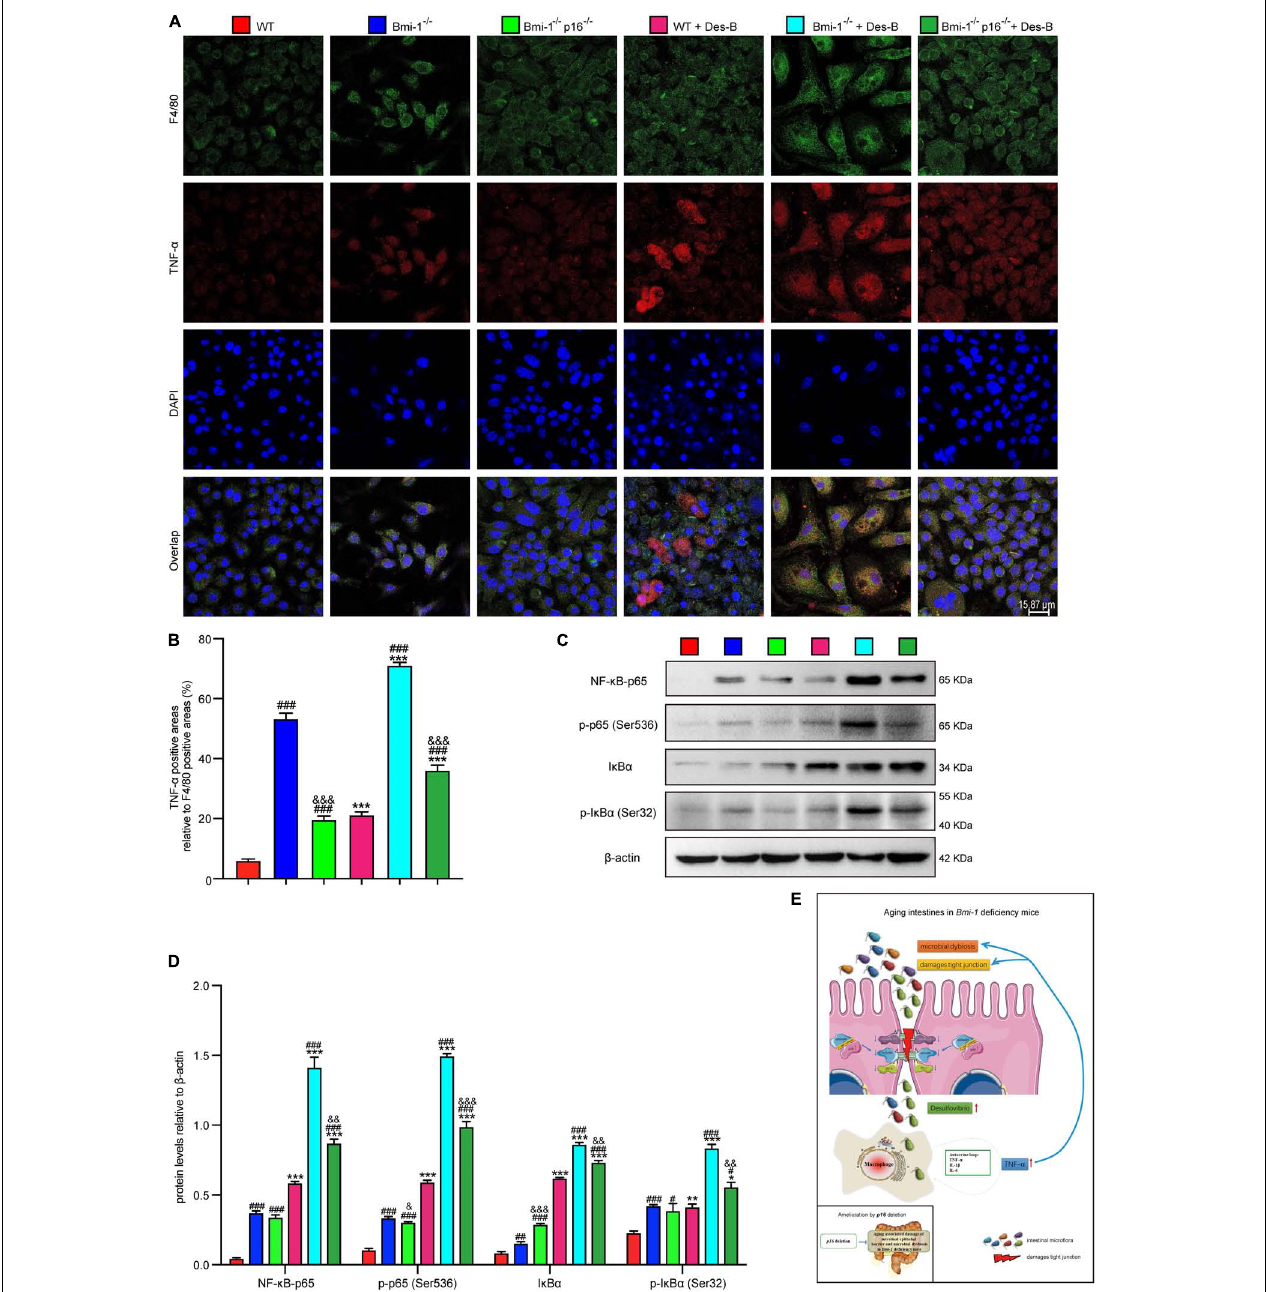
FIGURE 10 | Desulfovibrio promoted the TNF- α secretion and activated the NF- κ B signaling in BMDMs. BMDMs from WT, Bmi-1 − / − , and Bmi-1 − / − p16 − / − mice were pretreated with Desulfovibrio (10 µ g/mL) for 12 h. (A) Representative micrographs showing immunofluorescence for F4/80 and TNF- α , with DAPI staining the nuclei. (B) Percentage of TNF- α –positive areas relative to F4/80 (%). (C) Western blots for NF- κ B–p65, p-p65 (Ser536), I κ B- α , and p-I κ B α (Ser32) in BMDM cells from WT, Bmi-1 − / − , and Bmi-1 − / − p16 − / − mice; β -actin was used as the loading control. (D) Protein levels relative to β -actin were assessed by densitometric analysis. Statistical analysis was performed with one-way ANOVA test. Values are mean ± SEM from six determinations per group, ∗ p < 0.05, ∗∗ p < 0.01, ∗∗∗ p < 0.001 compared with the same genotype without Desulfovibrio treatment group; # p < 0.05, ## p < 0.01, ### p < 0.001 compared with WT-BMDM group at the same treatment; & p < 0.05, && p < 0.01, &&& p < 0.001 compared with the Bmi-1 − / − –BMDM group at the same treatment. (E) Graphical abstract about aging intestines in Bmi-1 –deficient mice. Macrophages-secreted TNF- α resulting from Bmi-1 deficiency not only stimulated macrophages to secrete more inflammatory factors, but also accelerated the intestinal microbiota disorders and destruction of TJ. Harmful bacteria including Desulfovibrio cross TJ to further trigger systemic inflammations. Up-regulated p16 in the intestine of Bmi-1 –deficient mice prevented occludin from forming and repairing intercellular TJ by combining with occludin protein at the 1st–160th residue in the cytoplasm, which exacerbated destruction of TJ. However, p16 deletion improved intestinal microbial function and maintained the intestinal epithelial barrier in Bmi-1 –deficient